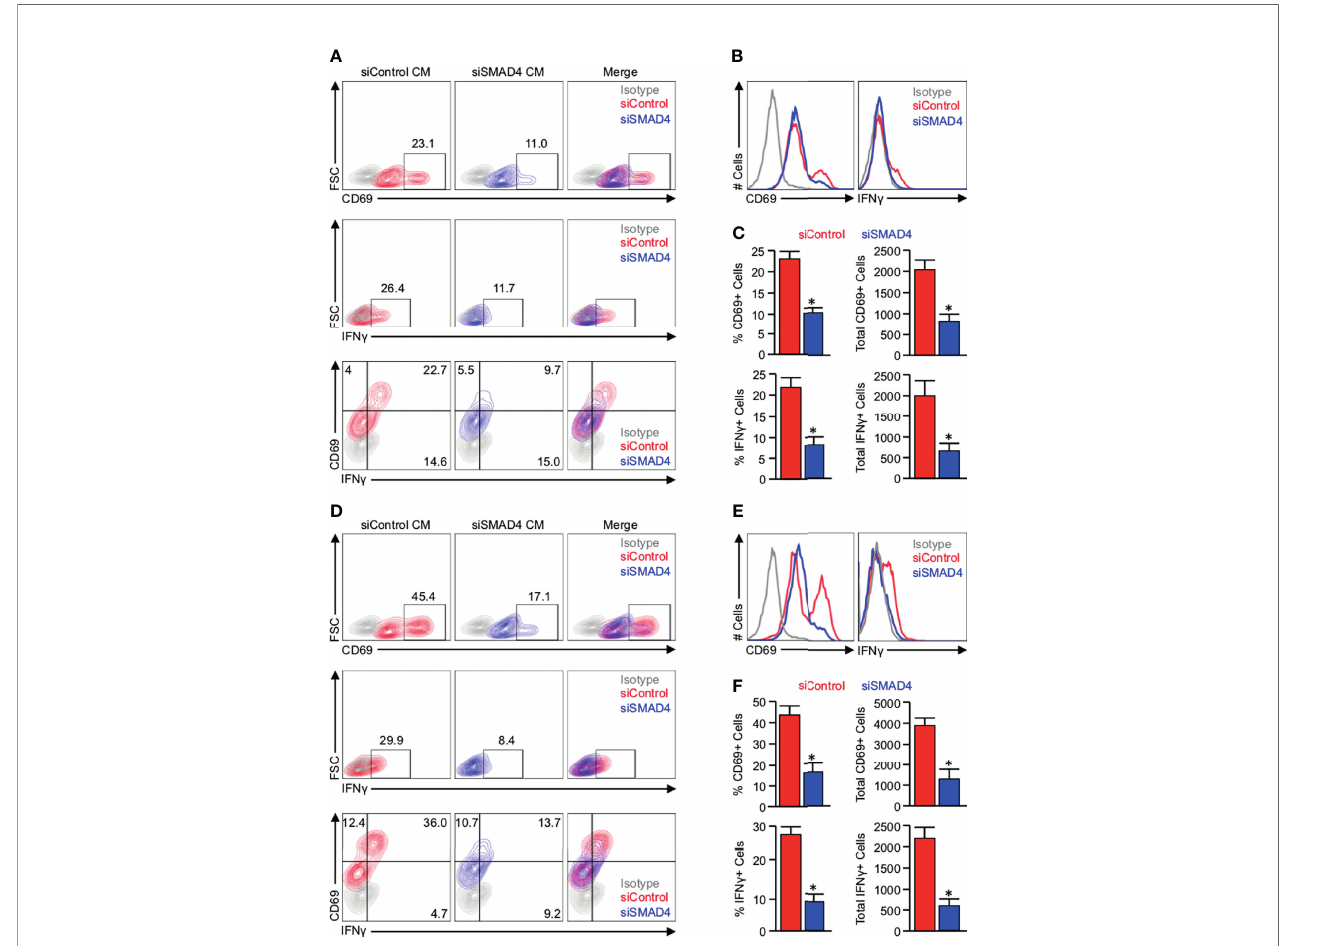
FIGURE 4 | JURKAT T-cells remain refractory from full activation when grown in conditioned media from SMAD4-de fi cient tumor cells. (A) PANC-1 tumor cells were incubated with either a control siRNA (siControl) or siRNA against SMAD4 (siSMAD4) and stimulated with 10ng/mL of recombinant TGF b 1 after 24 hours. Four hours after treatment, media was changed to serum-free DMEM and collected after another 24 hours. This media was supplemented with 10% FBS and 2 m l/mL ImmunoCult Human CD3/CD28 T Cell Activator and administered to 1 million serum-starved JURKAT T-cells. After 24 hours, JURKAT cells were collected, incubated with a protein transport inhibitor for one hour, and analyzed for T-cell activation by fl ow cytometry for the activation markers CD69, IFN g , or CD69 and IFN g . (B) The modal expression of CD69 and IFN g is displayed as a histogram plot. (C) Using the described gating, the relative percent of CD69+ and IFN g + events are plotted, as are the absolute number of each per 10,000 events (*p < 0.05). (D) MIA PaCa-2 tumor cells were incubated with either a siControl or siSMAD4, treated similarly, and media collected as described. This media was supplemented with 10% FBS and 2 m l/mL ImmunoCult Human CD3/CD28 T Cell Activator, and administered to 1 million serum-starved JURKAT T-cells, which were analyzed by fl ow cytometry as described previously. (E) The modal expression of CD69 and IFN g is displayed as a histogram plot. (F) Using the described gating, the relative percent of CD69+ and IFN g + events are plotted, as are the absolute number of each per 10,000 events. (*p <